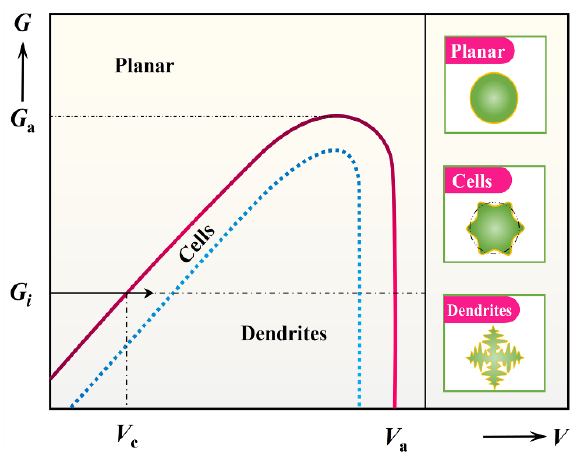
Figure 10. The evolution of S/L interface morphology during equiaxed solidification, where G and V are the critical temperature gradient and the critical growth rate for absolute stability, respec- tively. Reproduced with permission from Reference [67], Copyright © 2019 Elsevier B.V.